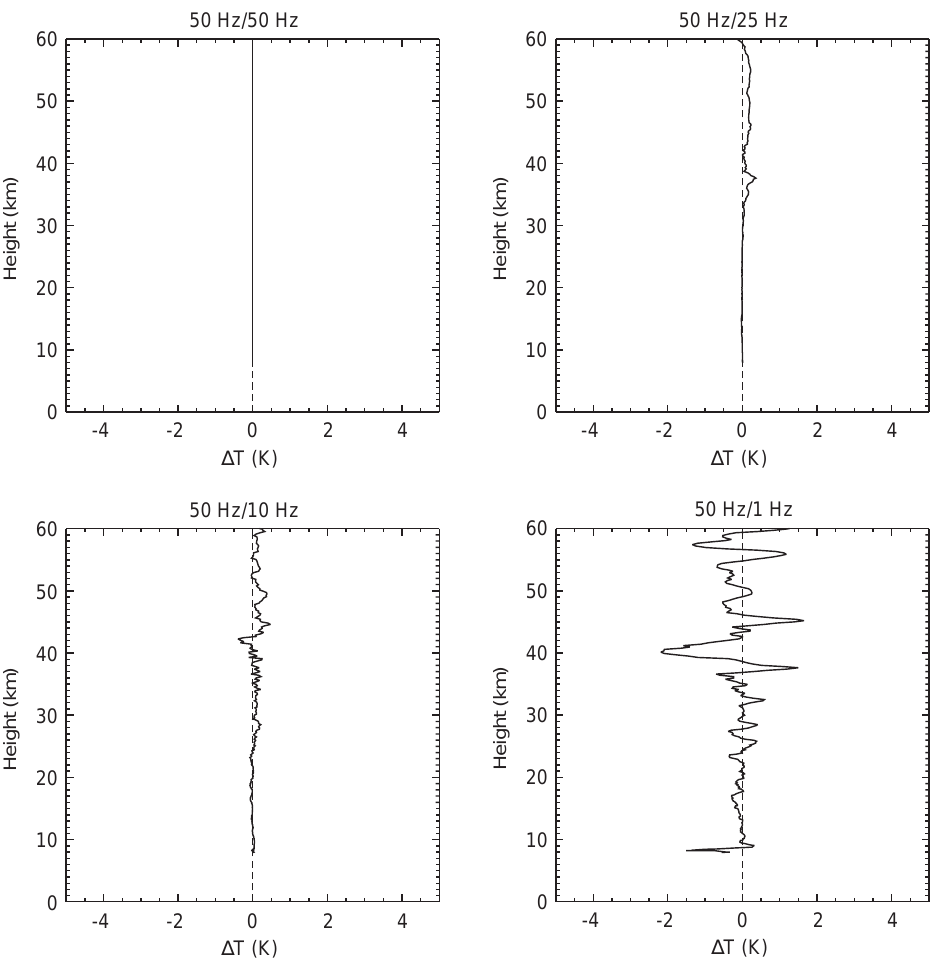
Fig. 2. The quality of ionospheric correction in case of reduced L 2 sampling rate is shown in terms of retrieved temperature di(cid:128)erences relative to an L 1 = L 2 baseline case of 50 Hz/50 Hz. Our ‘‘method of choice’’ (see text) for di(cid:128)erent L 1 = L 2 sampling ratios of 50 Hz/50 Hz,